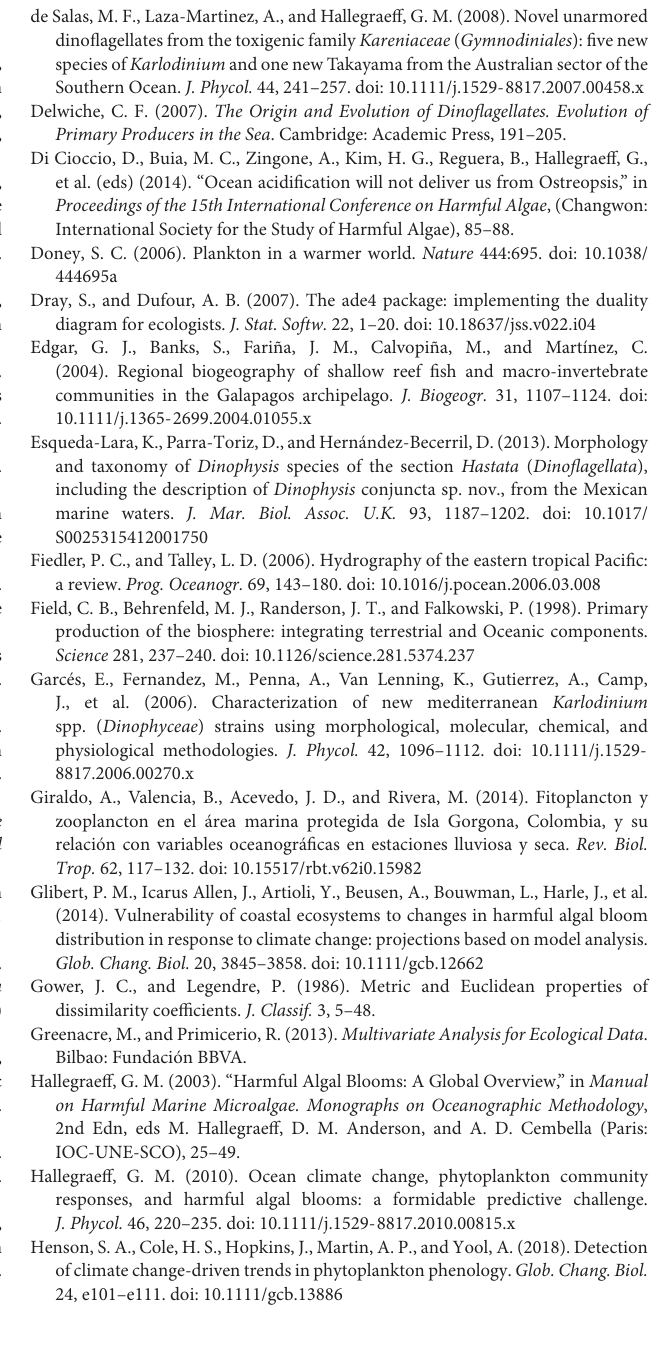
FIGURE S2 | Vertical profiles for temperature ( ◦ C). The information for each island and transect is showed in columns and rows, respectively. Station is color code: blue color for 2 nm, green color for 5 nm, and yellow color for 10 nm. FIGURE S3 | Vertical profiles for salinity. The information for each island and transect is showed in columns and rows, respectively. Station is color code: blue color for 2 nm, green color for 5 nm, and yellow color for 10 nm.